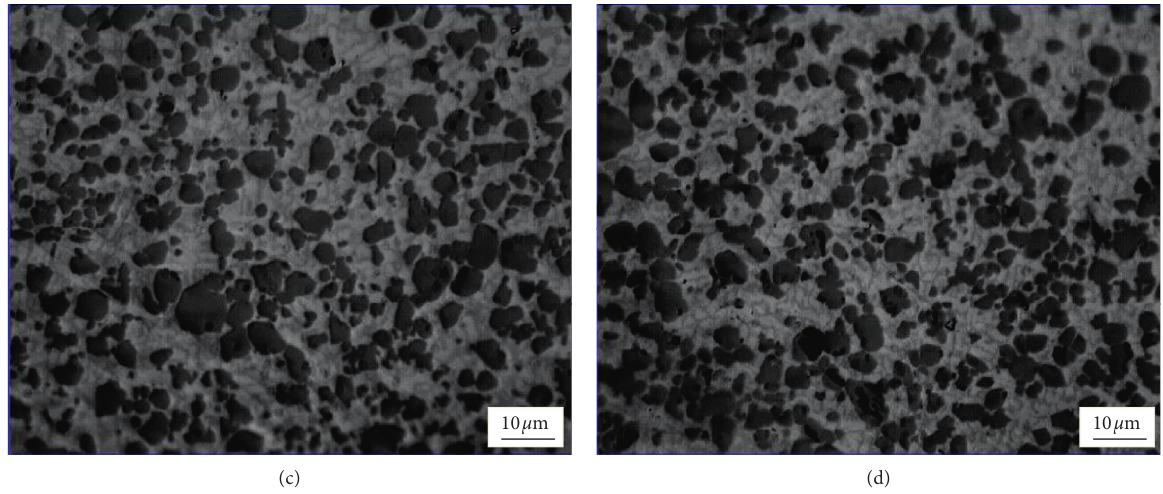
Figure 9: TiC morphologies of S3 coating: (a, b) bottom part; (c) middle part; and (d) upper part.